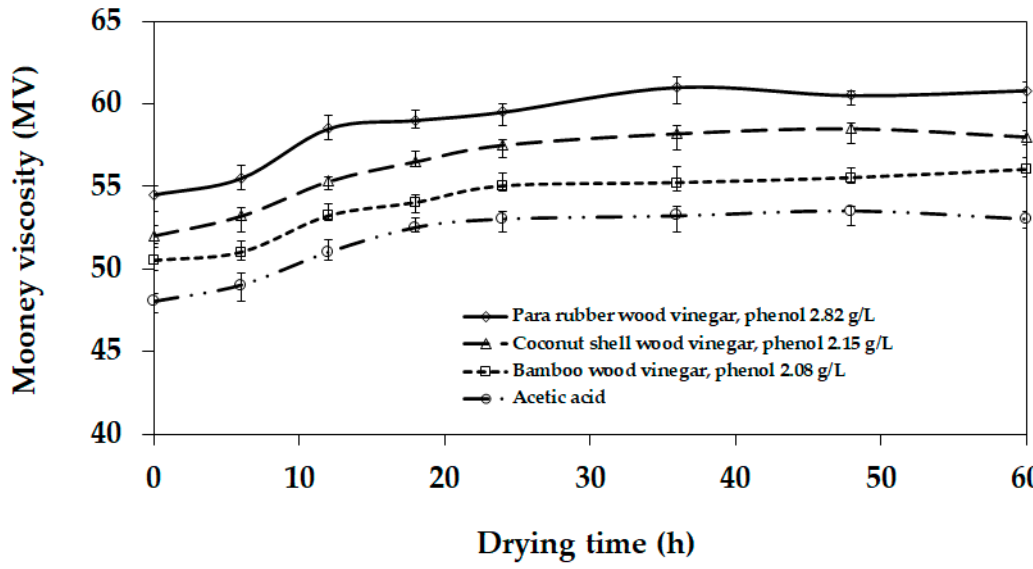
Figure 3. Mooney viscosity change during the drying process.